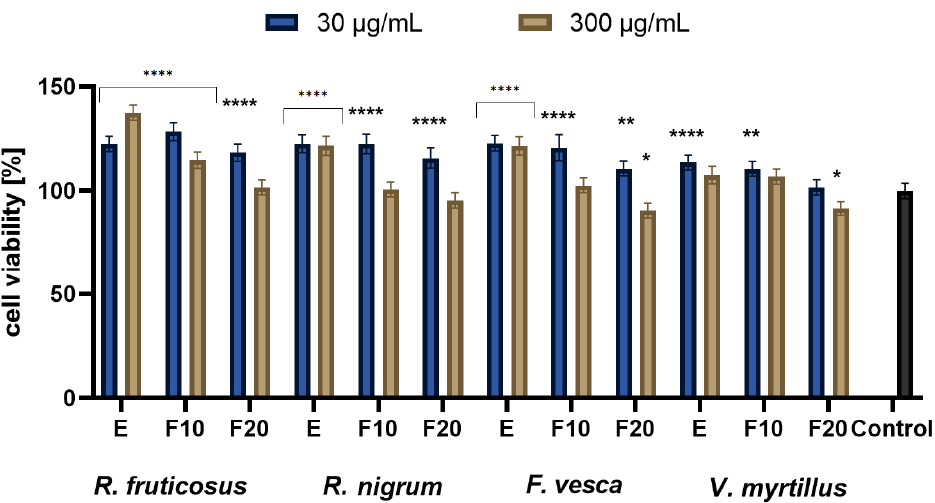
Figure 7. The effect of 24 h exposure of R. fruticosus L., R. nigrum L., F. vesca L., V. myrtillus L. extract and kombucha ferments (30 and 300 µ g/mL) on Neutral Red Dye uptake in cultured keratinocytes (HaCaT). Data are the mean ± SD of three independent experiments, each of which consists of three replicates per treatment group. **** p < 0.0001, ** p < 0.0045, * p < 0.0330 versus the control (100%).